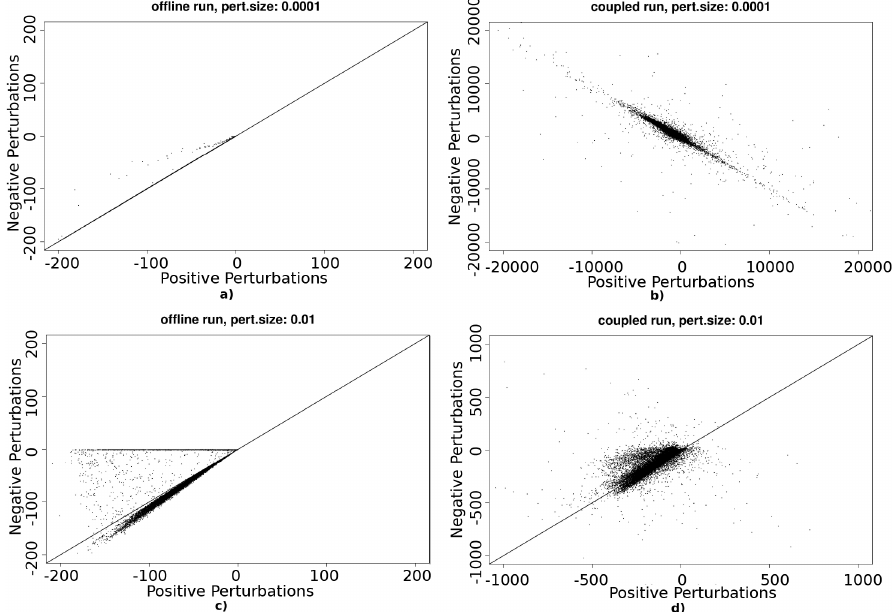
Figure 9. Assessment of the linearity assumption for the calculation of the Jacobians by means of finite differences. Plot of the Jacobian values for δT 2m /δW 2 on 2 July 2010, 12:00UTC of the positive perturbations against the values of the negative perturbations.